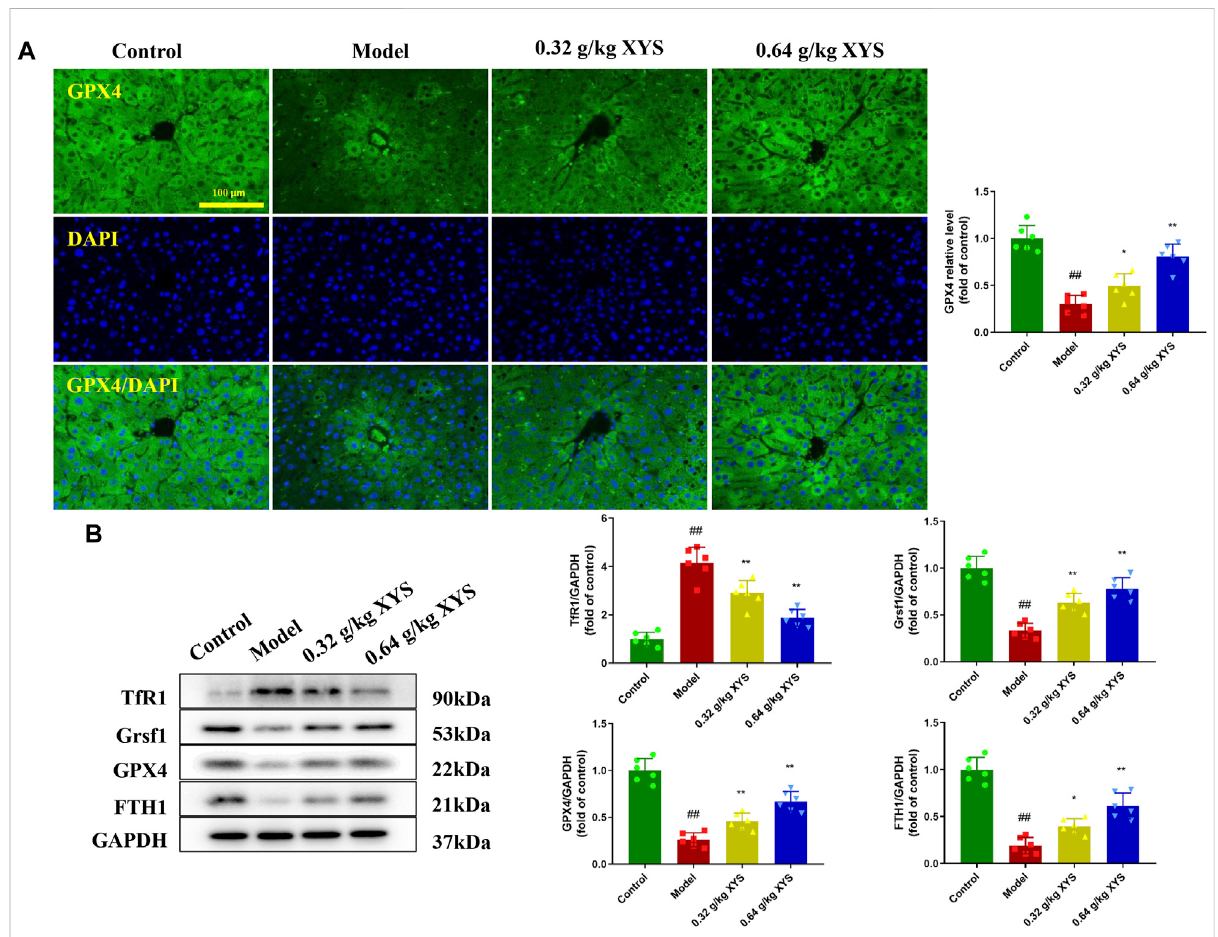
FIGURE 6 Immuno fl uorescenceofGPX4andtheexpressionofferroptosis-associatedproteins.MiceweretreatedwithXYS(0.32or0.64 g/kg) via gavage for three consecutive days and sacri fi ced on the fourth day. (A) Representative immuno fl uorescent images of GPX4 in liver tissues from each group, and relative quantitative histograms of GPX4, with each bar representing mean level of GPX4 in liver tissues ±SD. (B) Representative images of Western blot analyses of TfR1, Grsf1, GPX4, and FTH1 and their relative quantitative histograms. GAPDH was used as an internal control. # p < 0.05 vs. Control group, and ## p < 0.01 vs. Control group; p p < 0.05 vs. Model group and pp p < 0.01 vs. Model